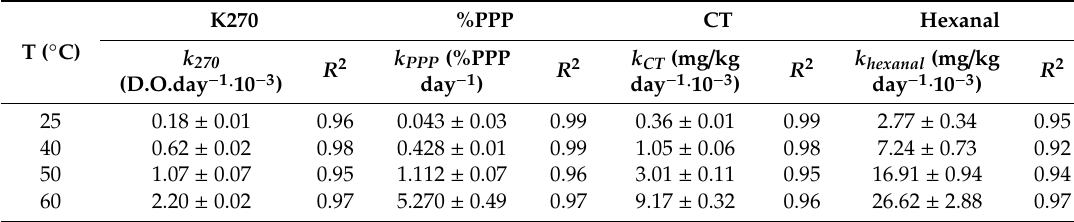
Table 2. Apparent zero-order reaction rate of K270, %PPP and CT of EVOO stored at 25, 40, 50 and 60 ◦